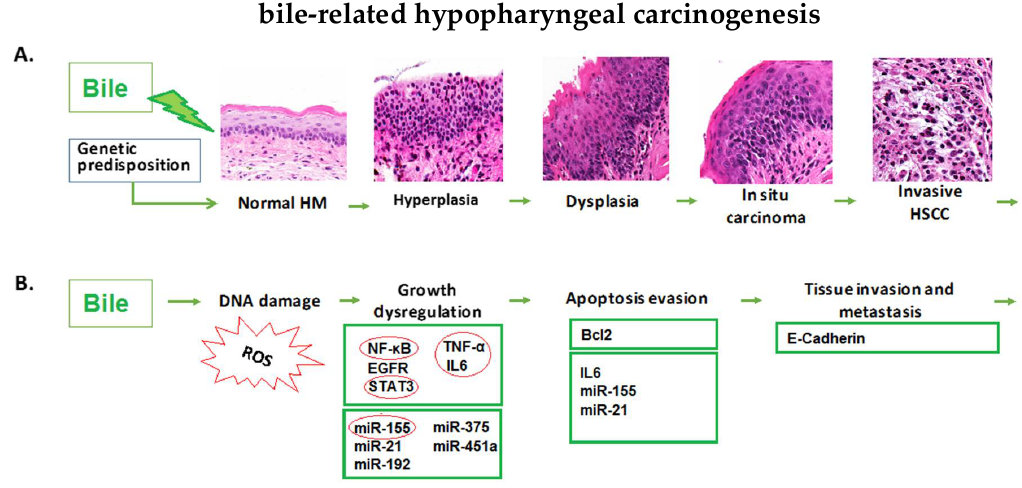
Figure 6. Bile and hypopharyngeal carcinogenesis. ( A ) In vivo model supporting the histologic progression in hypopharyngeal mucosa (HM) under the carcinogenic e ff ect of acidic bile refluxate. ( B ) Genetic alterations in HM caused by chronic bile exposure contribute to hypopharyngeal carcinogenesis. Biliary acidic refluxate causes oxidative damage resulting in high levels of ROS or double-strand breaks that can incur direct DNA damage. Direct DNA damage has been shown to lead to tumor-initiating mutations in head and neck cancer [42,43]. ROS can also activate several cancer-associated signaling pathways including NF- κ B [42]. Chronic exposure to acidic bile induces a systematic release of cytokines, such as IL-6 and TNF- α that are involved in oncogenic pathways [27]. Long-term exposure to acidic bile also induces a significant overexpression of Bcl2 , further supporting the anti-apoptotic e ff ect of chronic acidic bile refluxate in hypopharyngeal mucosa [27]. Acidic bile exposure of HM is also capable of directly inducing significant deregulation of cancer-related miRNAs, which are known regulatory molecules that mediate inflammation and tumorigenesis [31]. In particular, chronic intermittent exposure of HM to bile at a strongly acidic pH induces a profound upregulation of miR-155 , supporting a possible chronic inflammatory e ff ect associated with neoplastic events [30]. Long-term exposure to acidic bile induces a significant decrease of E-Cadherin consistent with progressive invasion. The combination of direct DNA damage and the NF- κ B-related anti-apoptotic deregulation